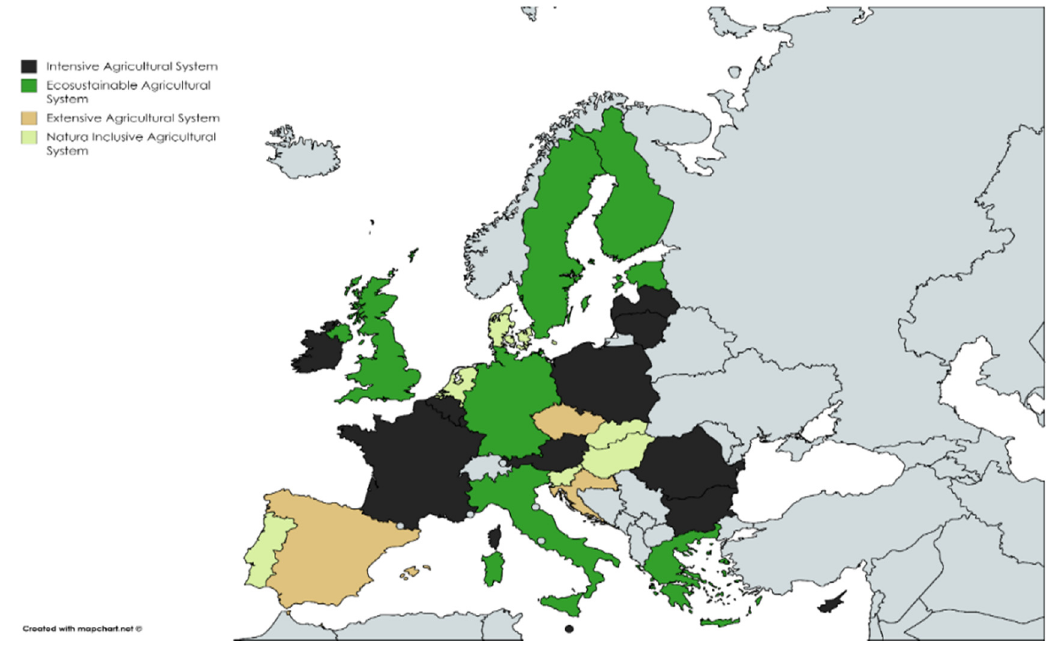
Figure 3. “Homogenous” European Union (EU) countries groups.